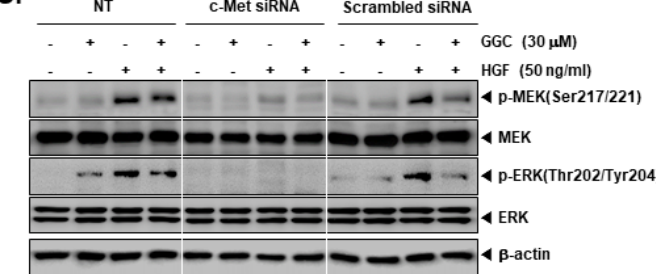
Figure 3. E ff ect of c-Met knock down on protein expression. HepG2 cells (5 × 10 4 cells / well) were transfected with 100 nM c-Met siRNA or scrambled siRNA for 48 h. The transfected cells were pre-treated with GGC (30 µ M) for 2 h, then HGF (50 ng / mL) treated for 30 min. Protein levels of various c-Met downstream signaling genes were measured by Western blotting. ( A ) Western blot analysis for p-c-Met (Tyr1234 / 1236) and c-Met. ( B ) Western blot analysis for p-PI3K (Tyr458), PI3K, p-Akt (Ser473), Akt, p-mTOR (Ser2448), and mTOR. ( C ) Western blot analysis for p-MEK (Ser217 / 221), MEK, p-ERK (Thr202 / Tyr204), ERK, and β -actin. The results shown are representative data of three independent experiments.